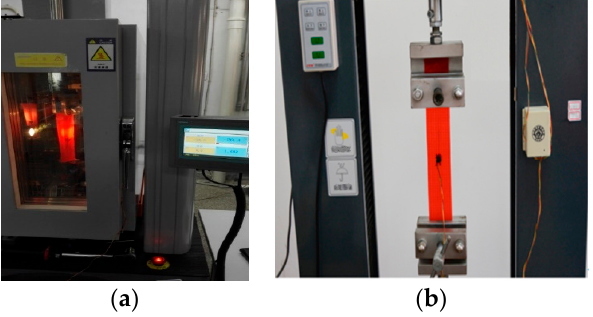
Figure 4. Experiments in THMTT machine. ( a ) Overall structure of the machine. ( b ) Core part of the testing machine.